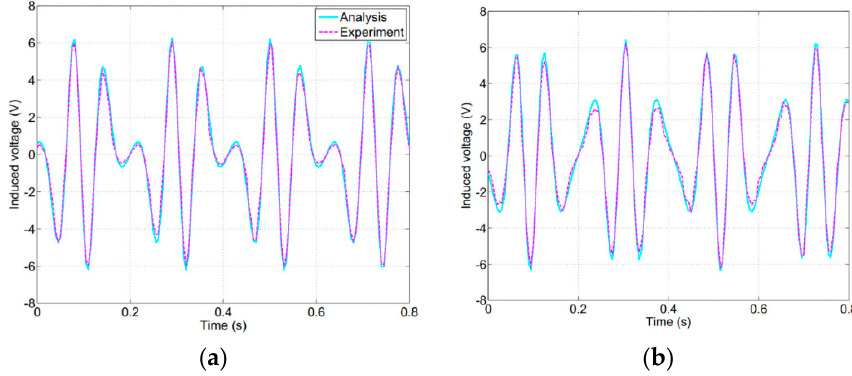
Figure 13. Comparisons between the experimental and modeling results of the induced voltages of coils under 2.4 Hz frequency and 30 mm amplitude: ( a ) coil 1 and ( b ) coil 2.